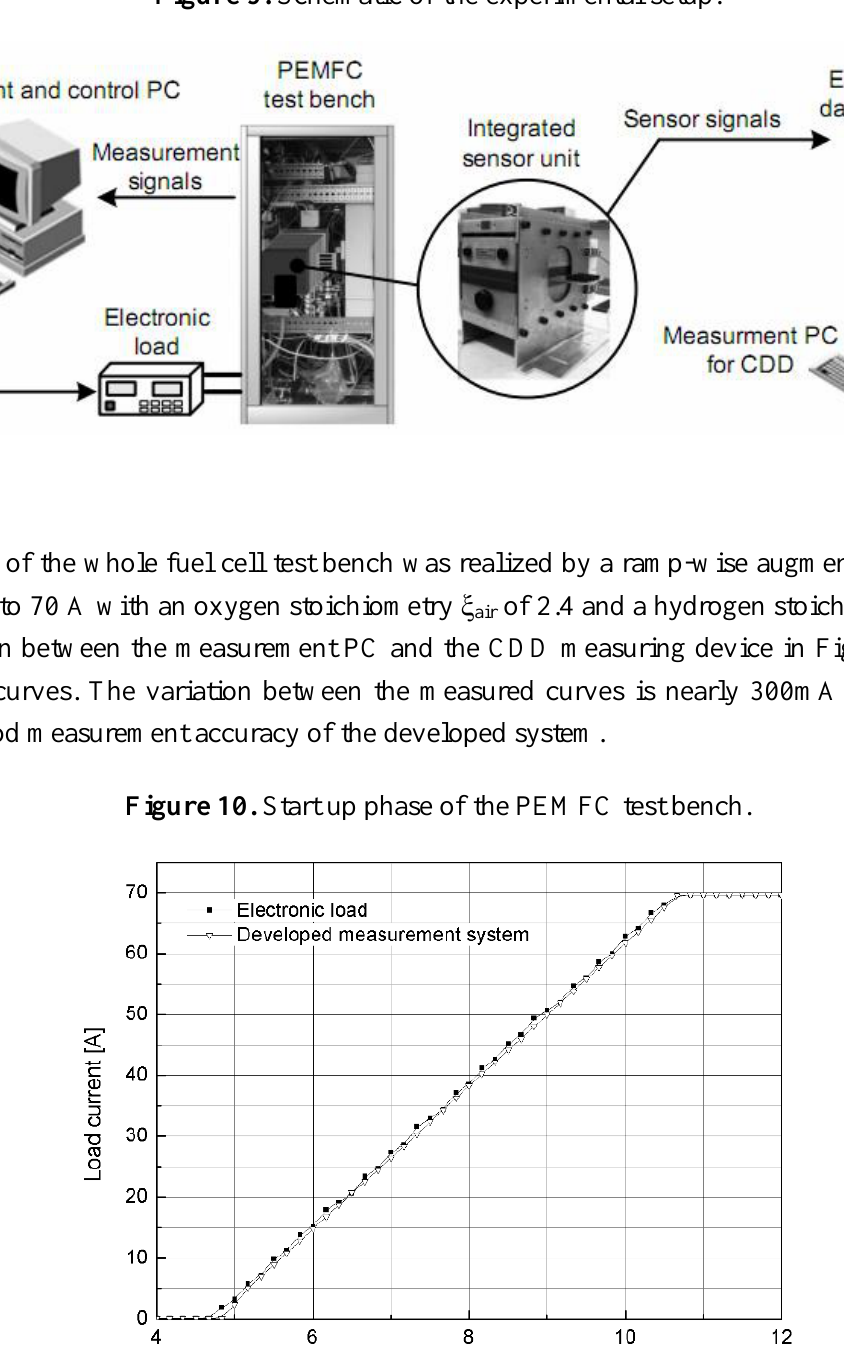
Figure 9. Schematic of the experimental setup.